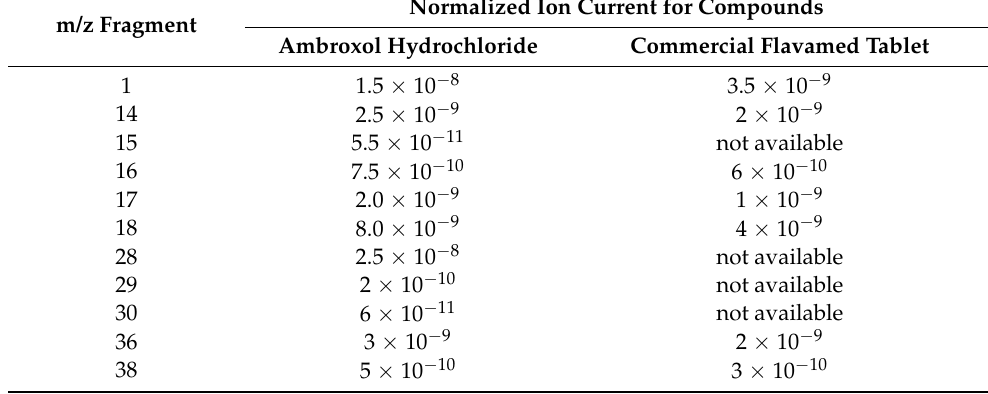
Table 1. Summarized identification results and normalized ion currents for investigated samples of ambroxol hydrochloride and commercial Flavamed ®